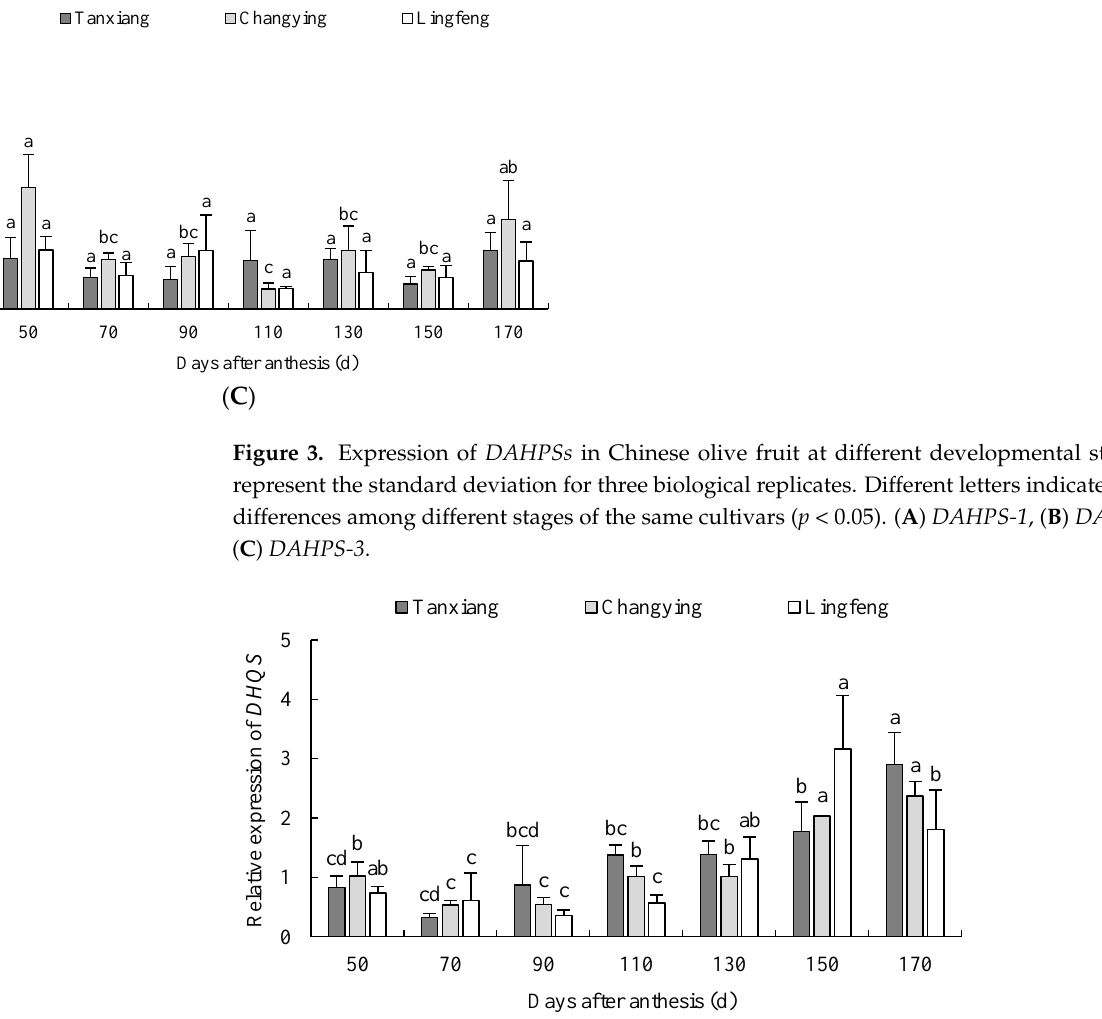
Figure 4. Expression of DHQS in Chinese olive fruit at different developmental stages. Bars represent the standard deviation for three biological replicates. Different letters indicate significant differences among different stages of the same cultivars ( p < 0.05).